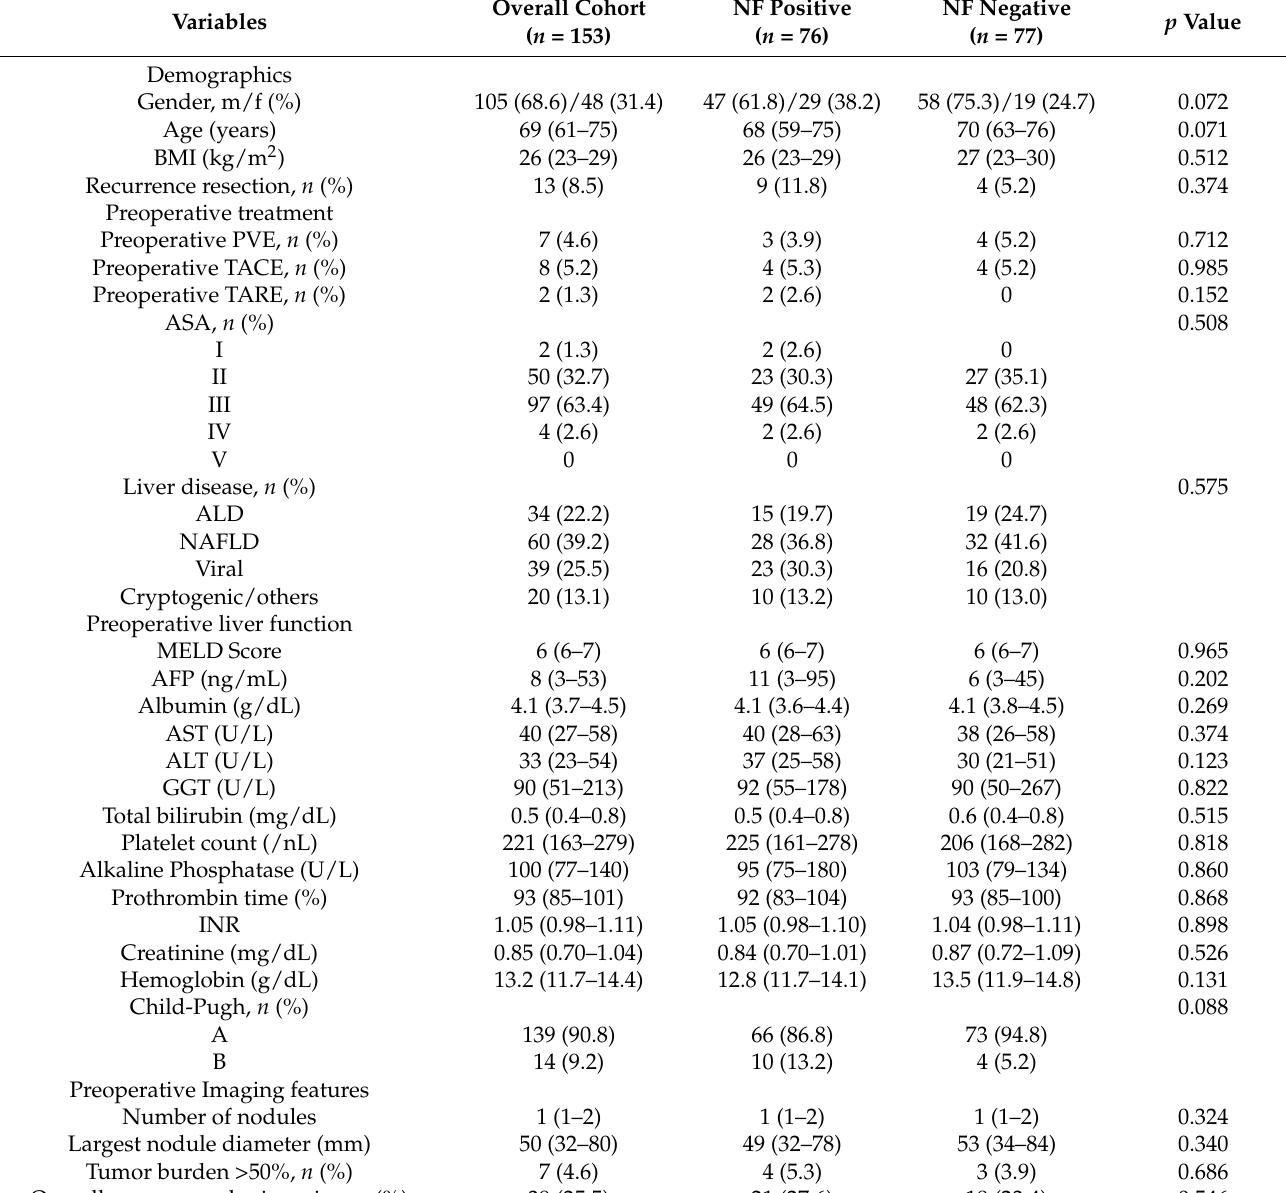
Table 1. Patients’